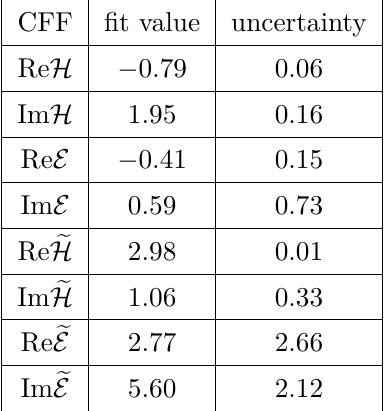
Table 5. Fitted CFF values from χ 2 minimization using all 8 polarization channels of the pseudodata depited in figure 7. The percent deviation is from the expected UVa model values shown in table 4. The uncertainties are computed via eq.